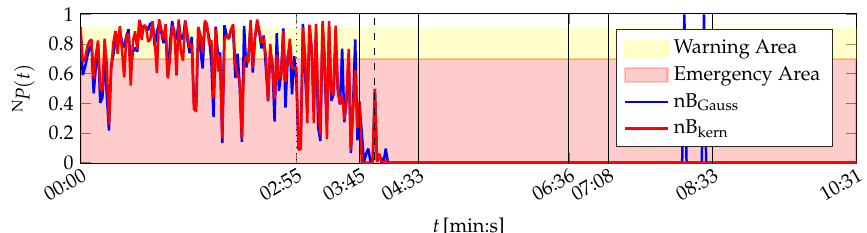
Figure 9. System health evaluation over time during manipulated operation of the printing unit demonstrator (PU manip ) by one-class naïve Bayes applying Gaussian (nB Gauss ) and kernel-density estimated (nB kern ) priors.